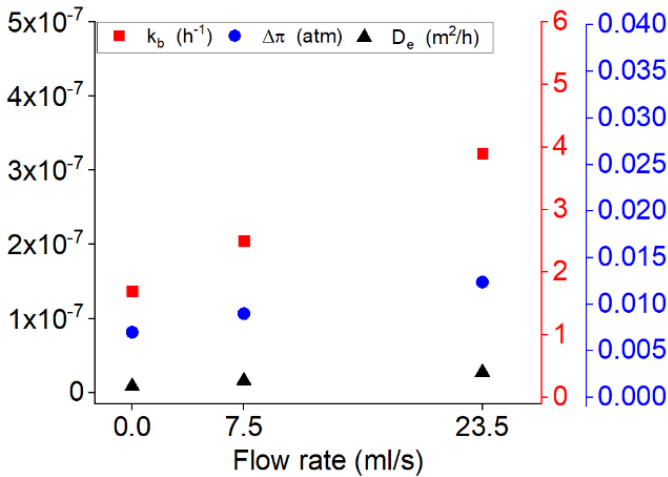
Figure 9. The variation of the release variables for the drug release from PU films with 20% of the drug at different flow rates of 0, 7.5 and 23.5 mL/s.